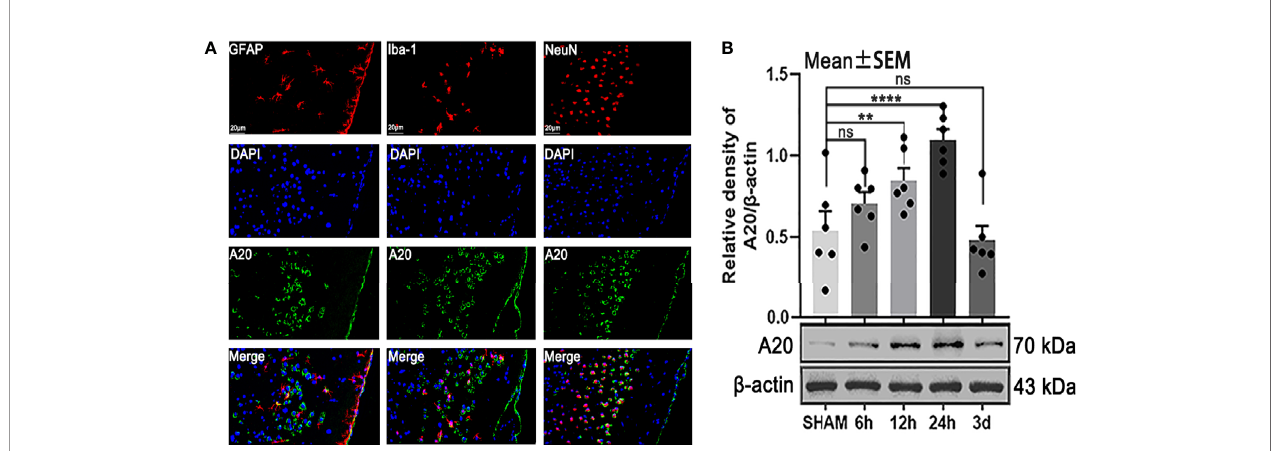
FIGURE 2 | The localization and time course of A20 expression after SAH. (A) Immuno fl uorescence images showed that A20 was expressed in astrocytes, microglia, and neurons. (B) Western blotting showed that the peak expression of A20 appeared at 24 h after SAH. Data are expressed as mean ± SEM, n = 6, ** p < 0.01, **** p < 0.001 versus sham, ns versus sham. ns, non-signi fi cant; NeuN, neuronal marker; GFAP, astrocyte marker; Iba-1, microglia